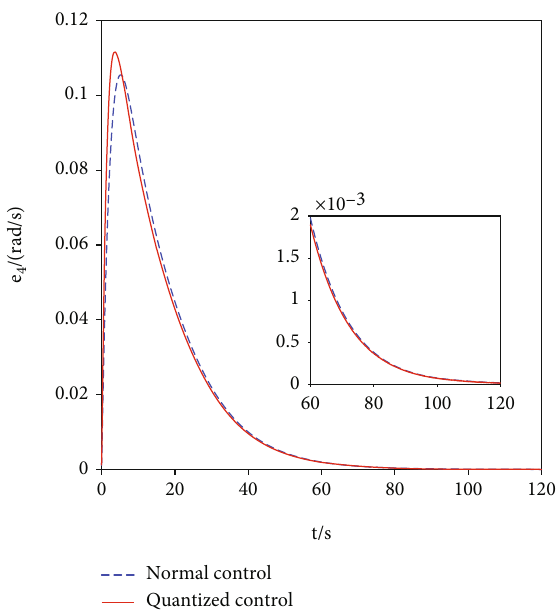
Figure 23: Curves of integration of control